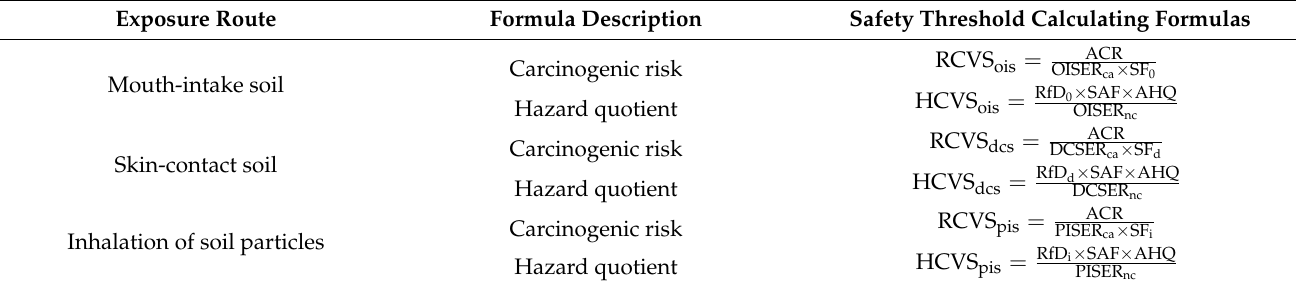
Table 4. Safety threshold calculating formulas for three soil exposure